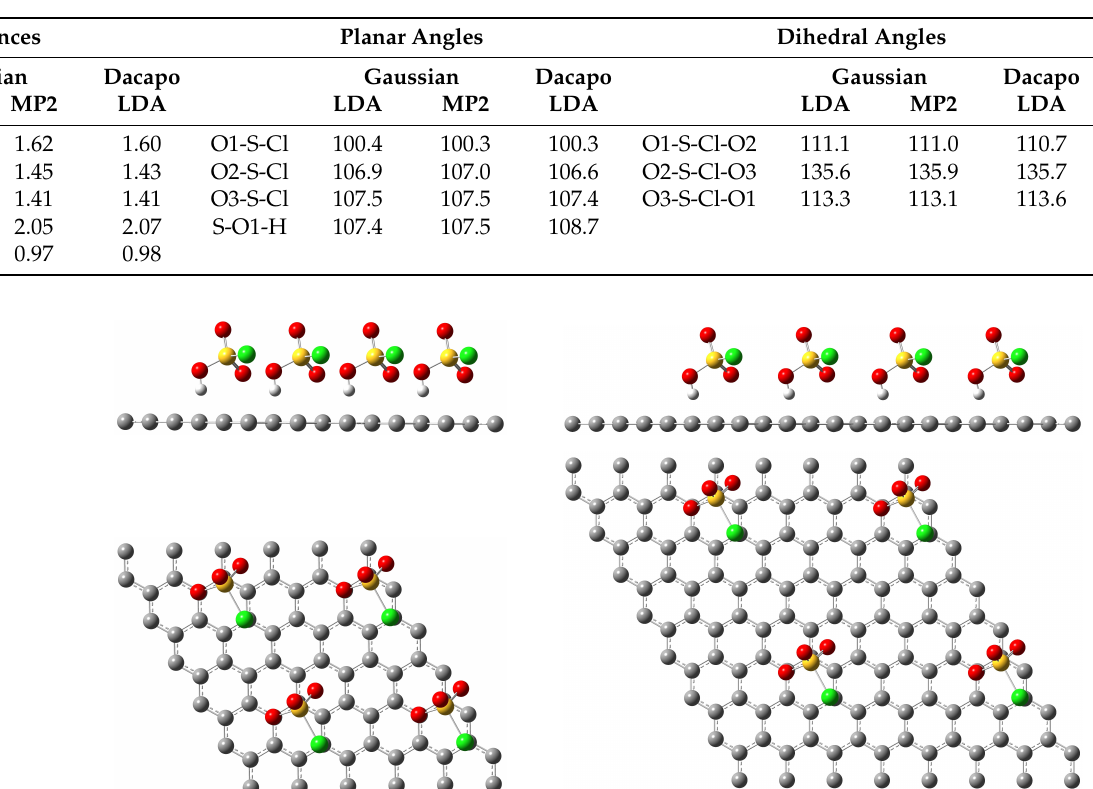
Figure 2. Geometric structure of a HSO 3 Cl molecule. Table 1. Calculated bond lengths (in Å), planar and dihedral angles (in degrees) for the chlorosulfonic acid molecule. Gaussian/Dacapo compared data.